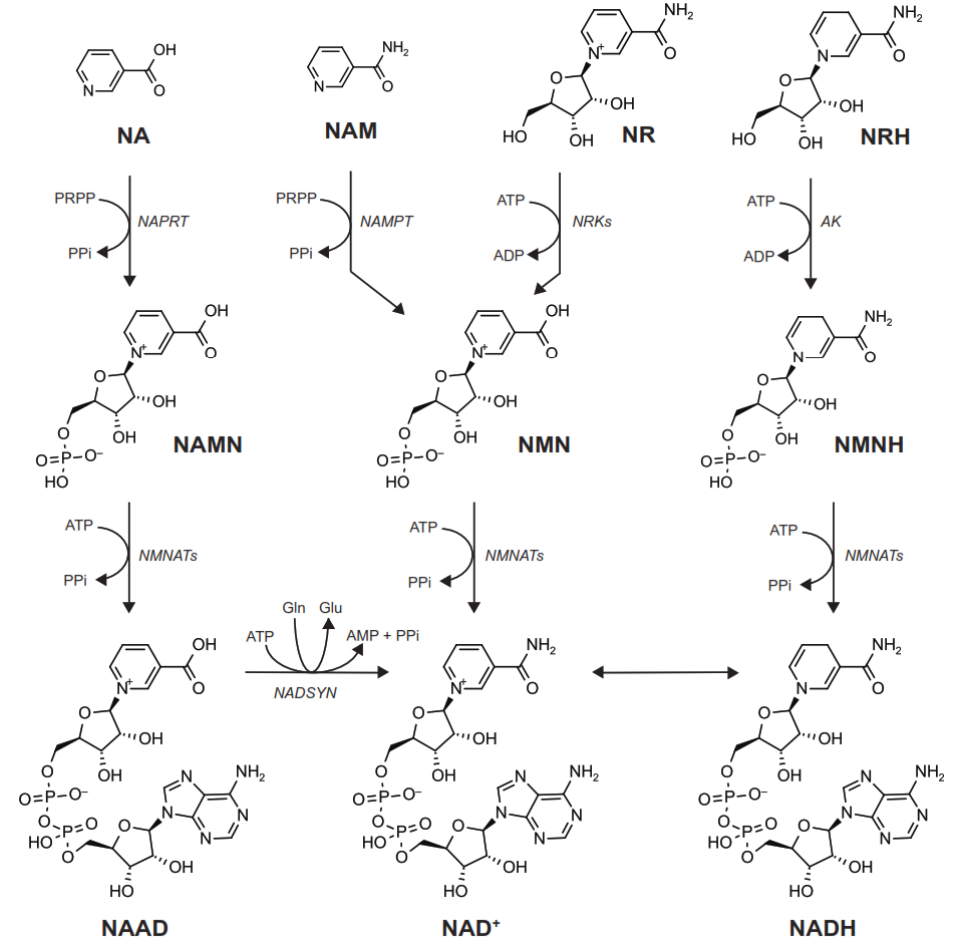
Figure 3. NAD + precursors use different routes and cofactors for NAD + synthesis: The graph illustrates the molecular structure, metabolic reactions, and cofactors required for non-ribosylated (i.e., nicotinic acid (NA), nicotinamide (NAM)) and ribosylated (i.e., nicotinamide riboside (NR), dihydronicotinamide riboside (NRH)) precursors to synthesize NAD + . NA and NAM require an initial ribosylation reaction catalyzed by the NA phosphoribosyltransferase (NAPRT) and NAM phosphoribosyltransferase (NAMPT) transferases, using phosphoribosyl pyrophosphate (PRPP) as the ribose donor and releasing inorganic pyrophosphate (PPi). In the case of NA, a second reaction catalyzed by the nicotinamide mononucleotide (NMN) adenylyltransferase enzymes (NMNATs) condenses NA with the adenosine monophosphate (AMP) moiety of ATP, rendering NA adenine dinucleotide (NAAD) and releasing PPi. NAAD is then transformed to NAD + through the NAD synthase (NADSYN) enzyme. In this reaction, NAAD is amidated to NAD + , while deamidating glutamine (Gln) into glutamate (Glu). In the case of NAM, its ribosylation leads to NMN synthesis. NMN is then transformed to NAD + via NMNAT enzymes. The two ribosylated precursors, NR and NRH, initiate NAD + synthesis through a phosphorylation step catalyzed by NR kinases (NRKs) and adenosine kinase (AK), respectively. Upon phosphorylation, NR generates NMN, which can be transformed to NAD + by NMNATs. In contrast, NRH generates NMNH, which NMNATs transform to NADH, later being oxidized to NAD +